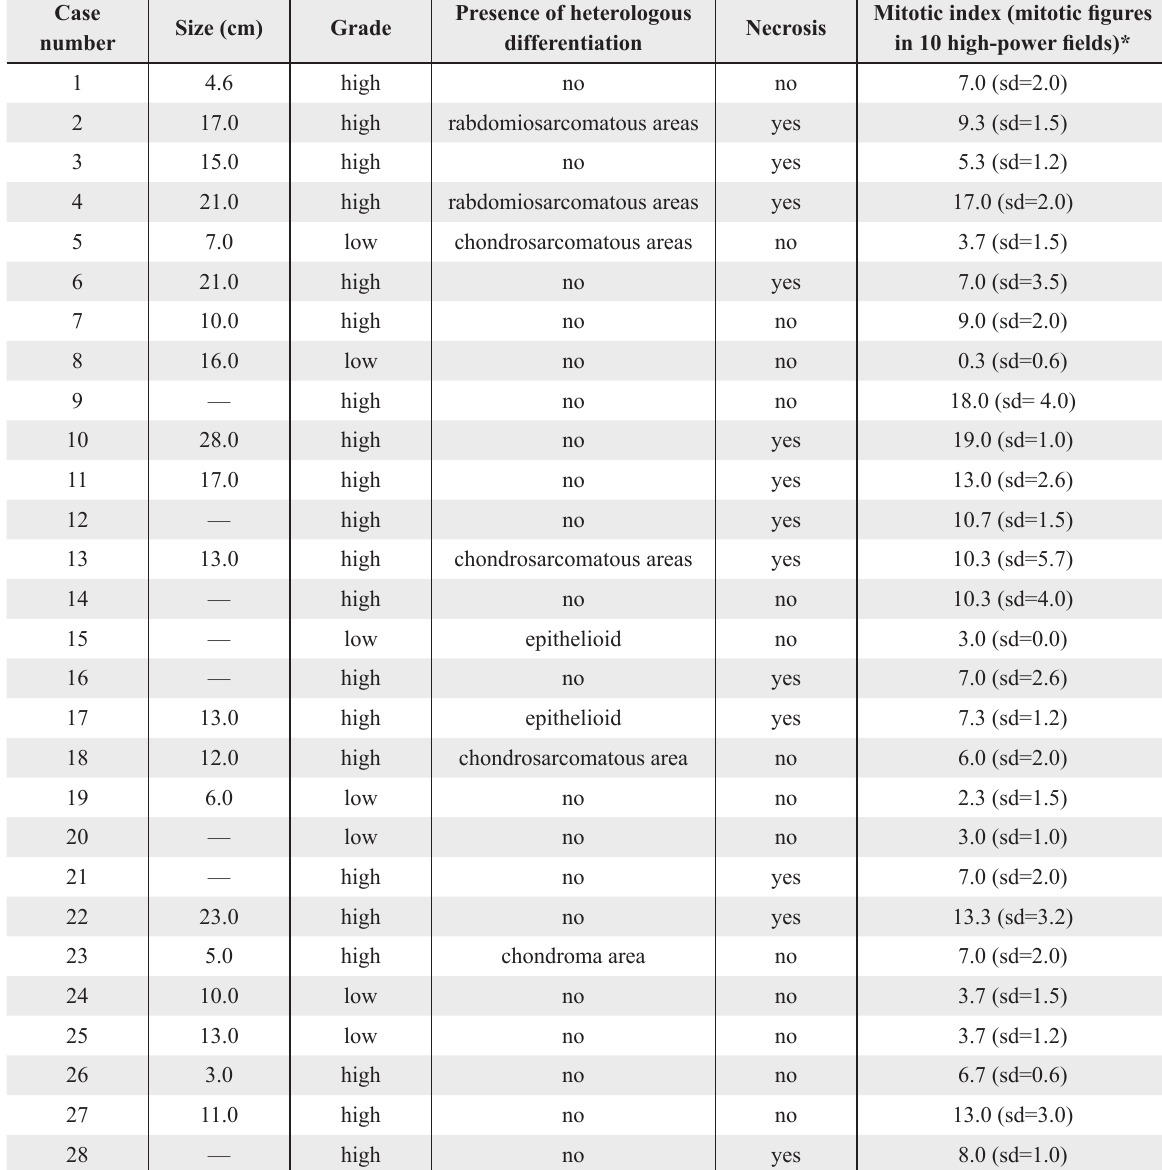
Pathological data of the malignant peripheral nerve sheath